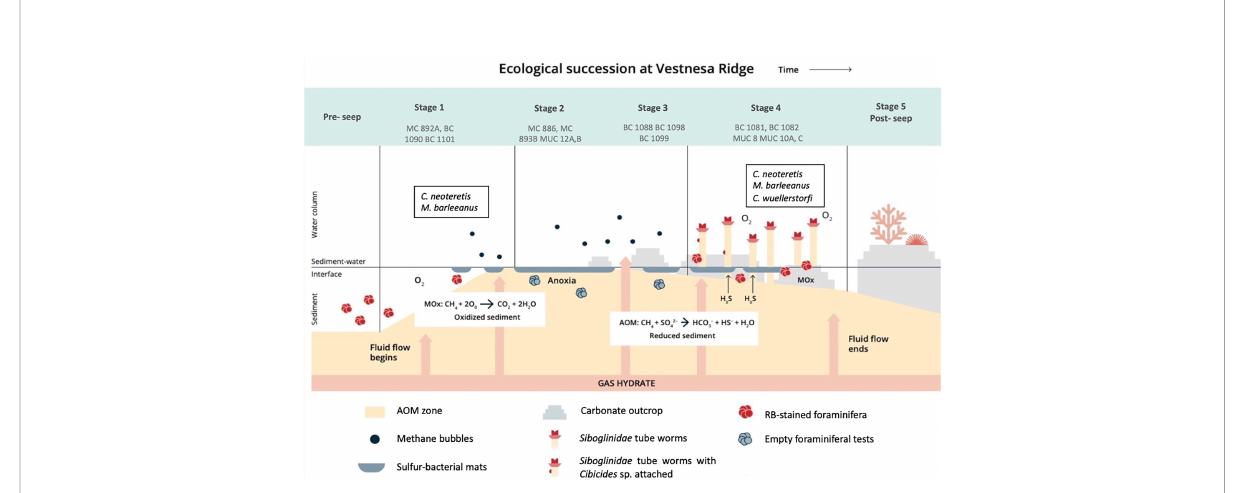
FIGURE 6 The proposed course of environmental and ecological successions at Vestnesa Ridge. Stage 5 has not (yet) been observed at